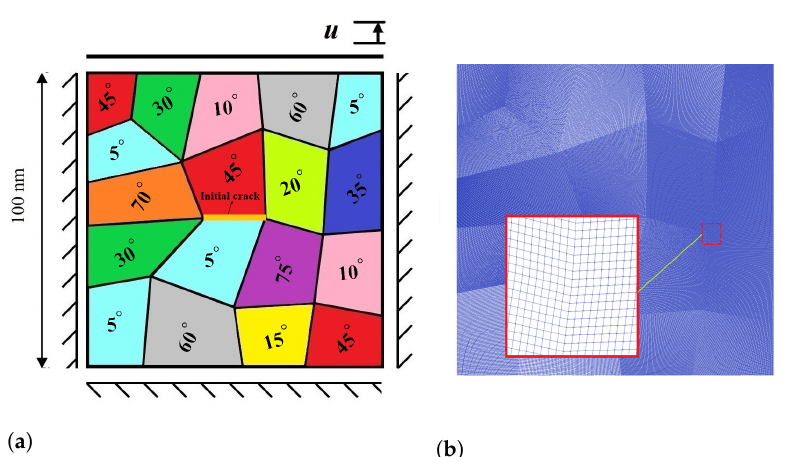
Figure 14. ( a ) Configuration of the polycrystalline specimen; ( b ) finite element mesh of the polycrys- talline